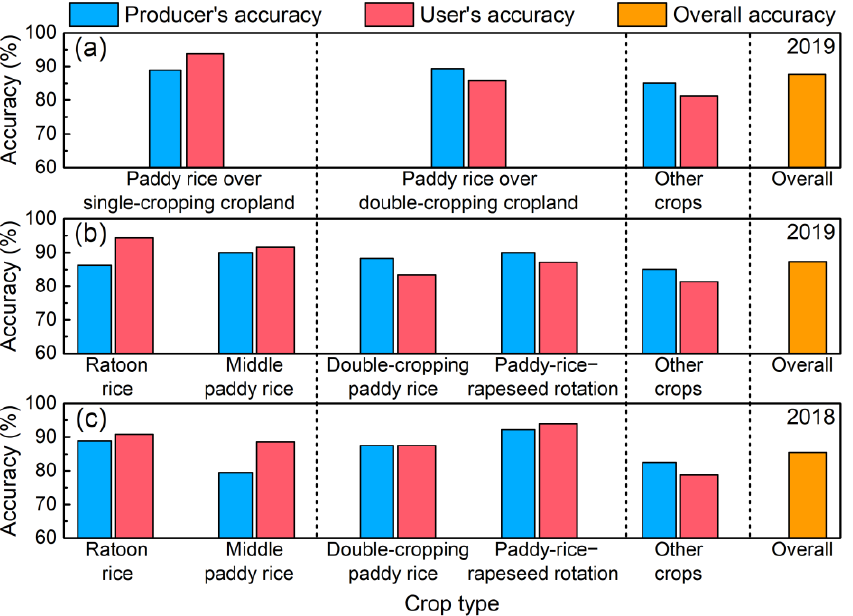
Figure 12. Evaluation of the derived ( a ) paddy rice cropping intensity map in 2019, ( b ) PRCPs in 2019 and ( c ) PRCPs in 2018 based on crop field samples.